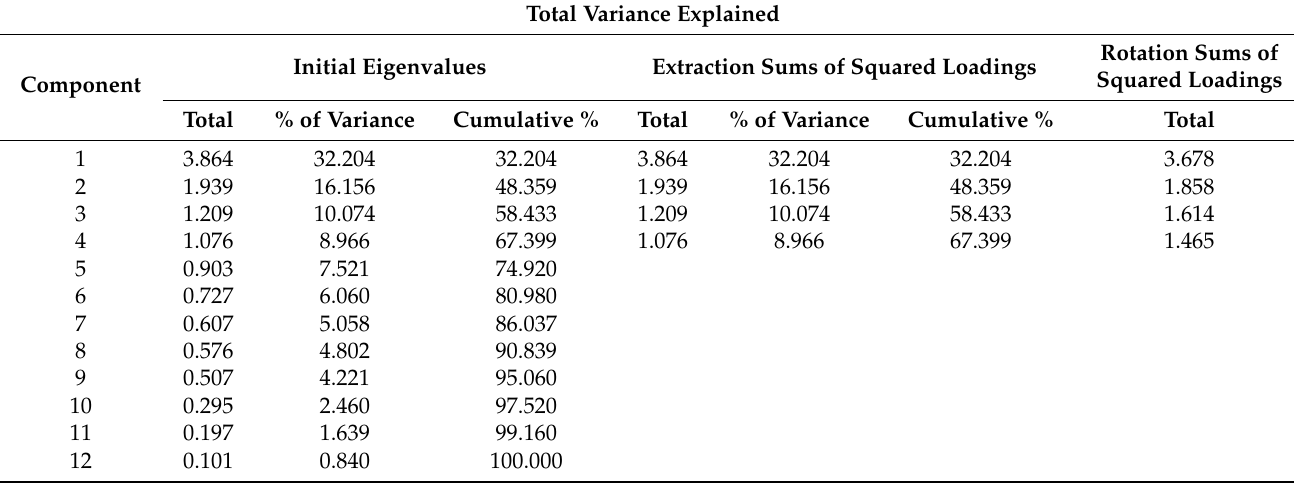
Table 5. Total variance explained from the main